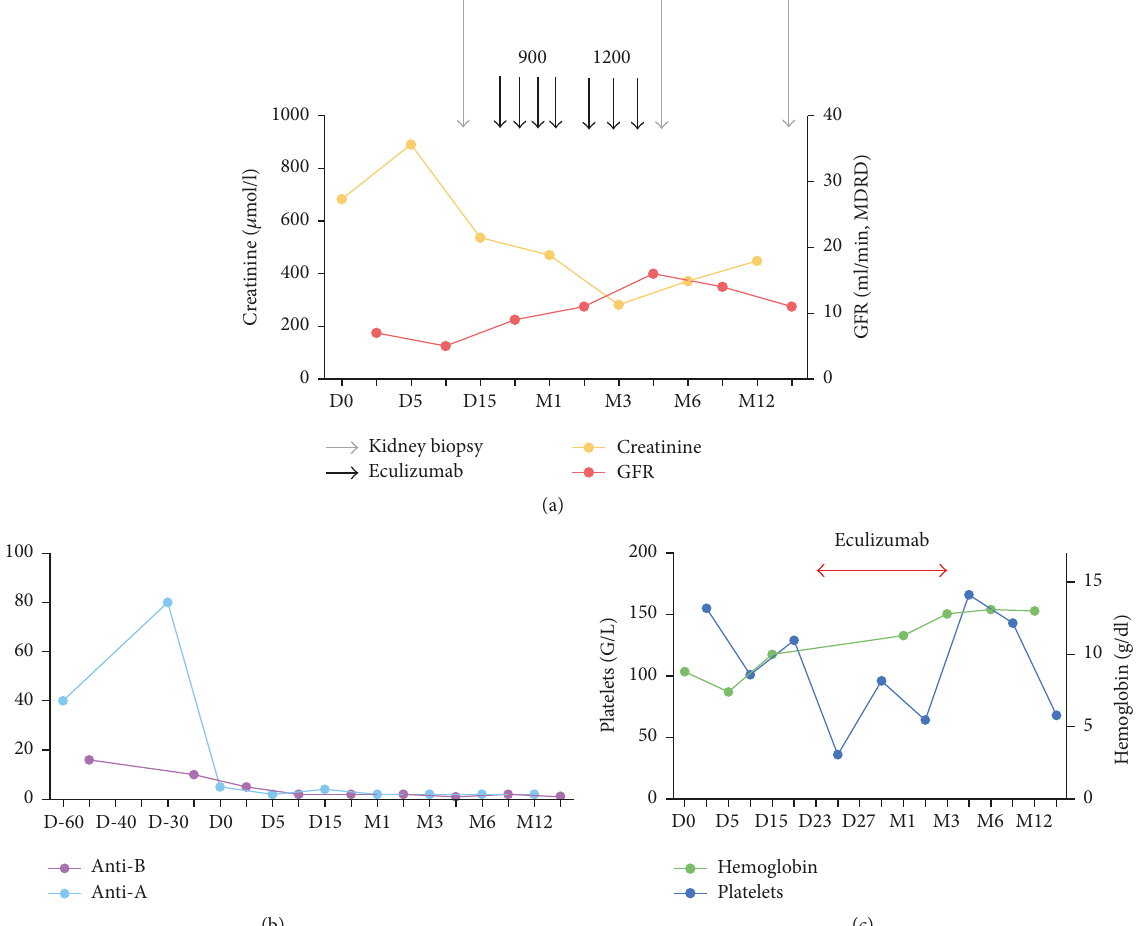
Figure 1: Kidney function (a), isoagglutinin titers (b), and hematological parameters (c) in patient 1. Evolution after kidney transplantation.